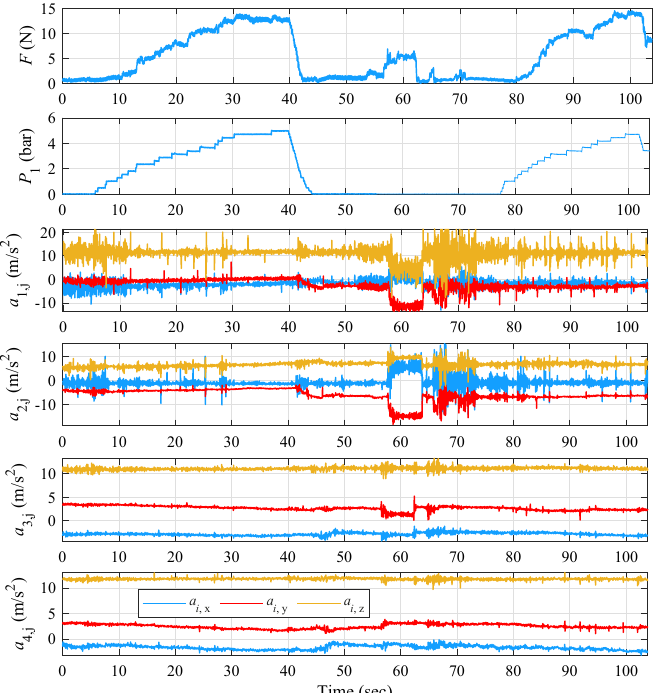
Figure 10. Experimental evaluation of iteration (A) and the effect of applying resisting force on the ET-diagnosed volunteer’s index-finger under open-loop changes in applied pressure and while the hand is at extended pose and performing a voluntary movement; Exp.